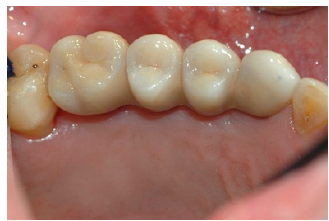
Figure 14. Cementing the Figure 14. Cementing the superstructure. Figure 14. Cementing the superstructure. Figure 14. Cementing the superstructure. Figure 14. Cementing the superstructure.